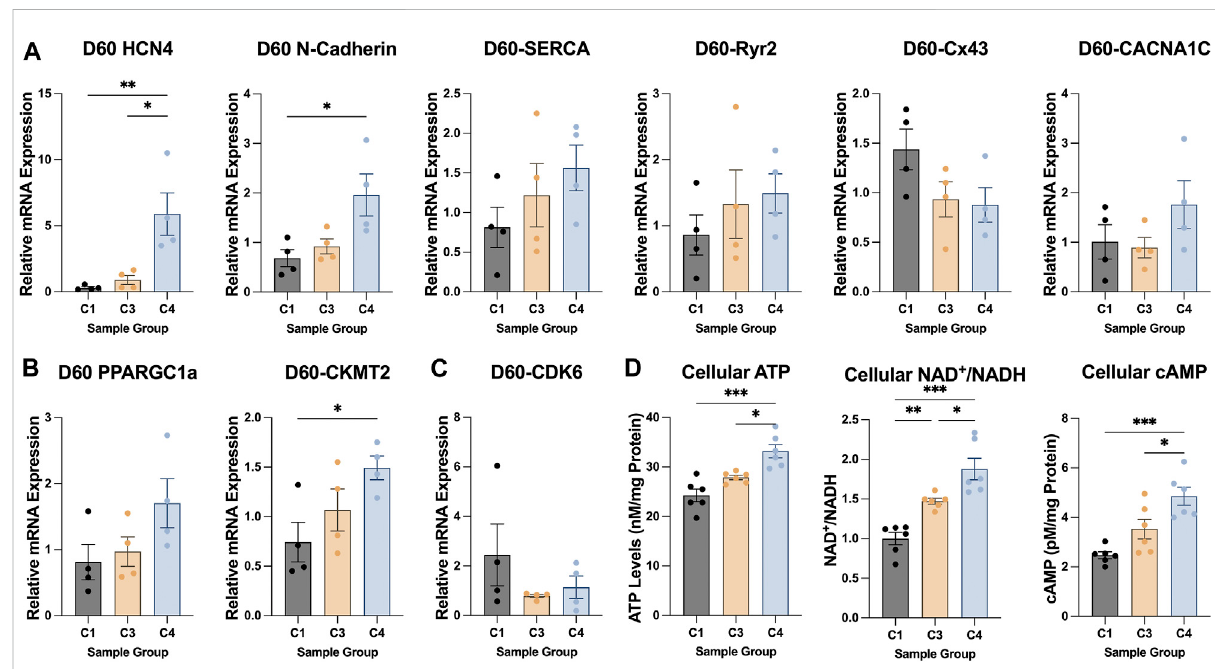
FIGURE 5 Patterns of metabolic, electrical, and cell-cycle gene expression in C1, C3, and C4 spheroids. The magnitude of expression for genes that contribute to CM (A) electrical conduction (HCN4, N-cadherin, SERCA, Ryr2, Cx43, CACNA1C), (B) metabolism (PPARGC1a, CKMT2), and (C) cell- cycle activity (CDK6) was evaluated in C1, C3, and C4 spheroids on D60 (C1 black; C3 yellow; C4 blue) via qPCR; measurements were normalized to intrinsic GAPDH mRNA abundance. (D) ATP abundance, the NAD/NADH ratio, and cellular cAMP was evaluated in C1, C3, and C4 spheroids on D60(C1black;C3yellow;C4blue) via luminescentATPdetectionassay,colorimetricassay,anddirectcAMPELISArespectively(* p < 0.05,** p < 0.01; n > 4 per